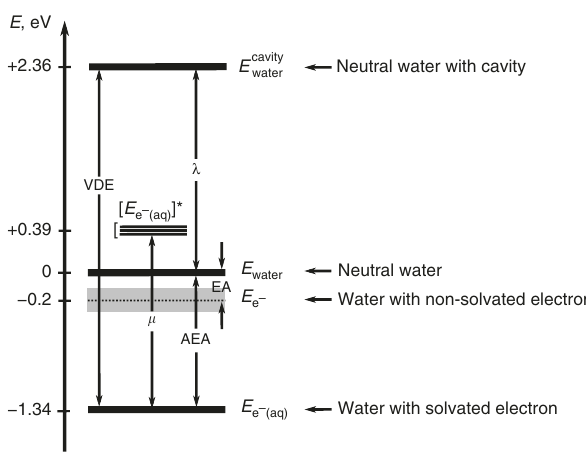
Fig. 2 Energy diagram of an electron in water. The energies reported in this diagram are from the most recent experimental results available in the literature and the value of the vertical electron af fi nity (EA) is determined in this work (0.1 – 0.3 eV). The vertical detachment energy of the solvated electron is VDE = 3.7 eV 47 and the adiabatic electron af fi nity of water is AEA = 1.34 eV 46 . The difference between VDE and AEA is the water reorganization energy upon solvation of an electron: λ = 2.36 eV; note the difference of more than 1 eV with the values used in the left panel of Fig. 3. (cid:1) (cid:3) (cid:3) corresponds to the excited state of the solvated electron e − (aq), E e (cid:2) aq ð Þ with excitation energy μ = 1.73 eV 48 . All values are in eV